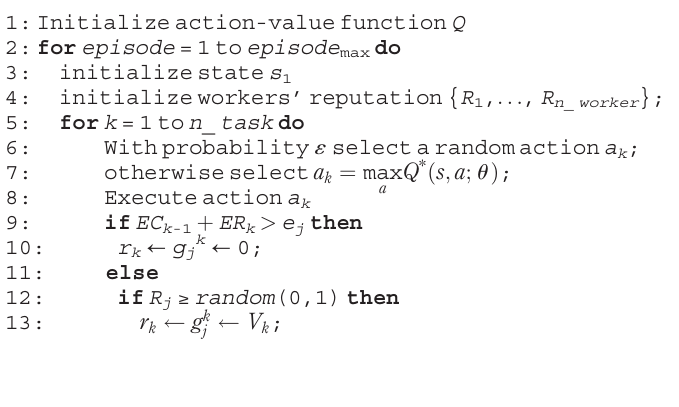
Algorithm 1 Learning the Policy